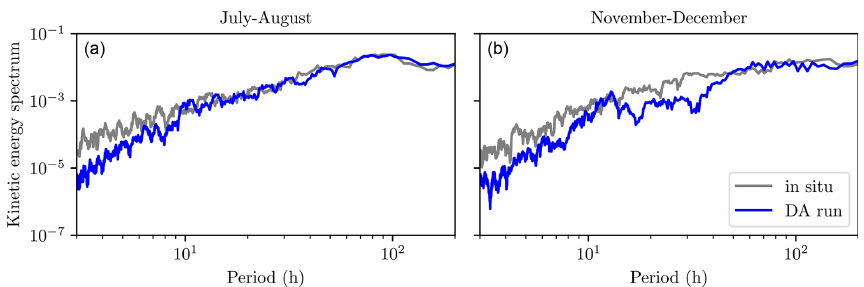
Figure 10. Kinetic energy spectra computed from the ADCP sensors at the LéXPLORE platform (gray) and from the DA run (blue). Profiles based on 15m deep dynamics use July–August data for panel (a) and November–December data for panel (b) .